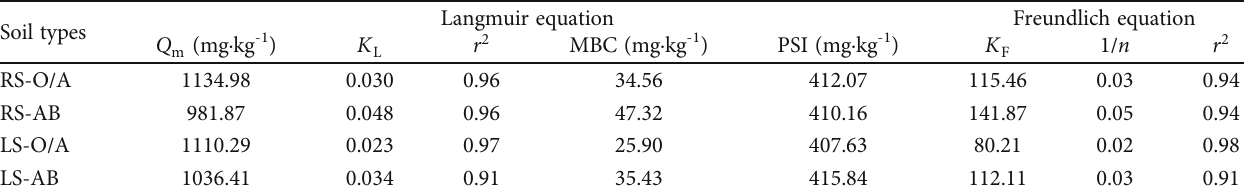
(Table 1). The K value of red soil (0.030-0.048) was L